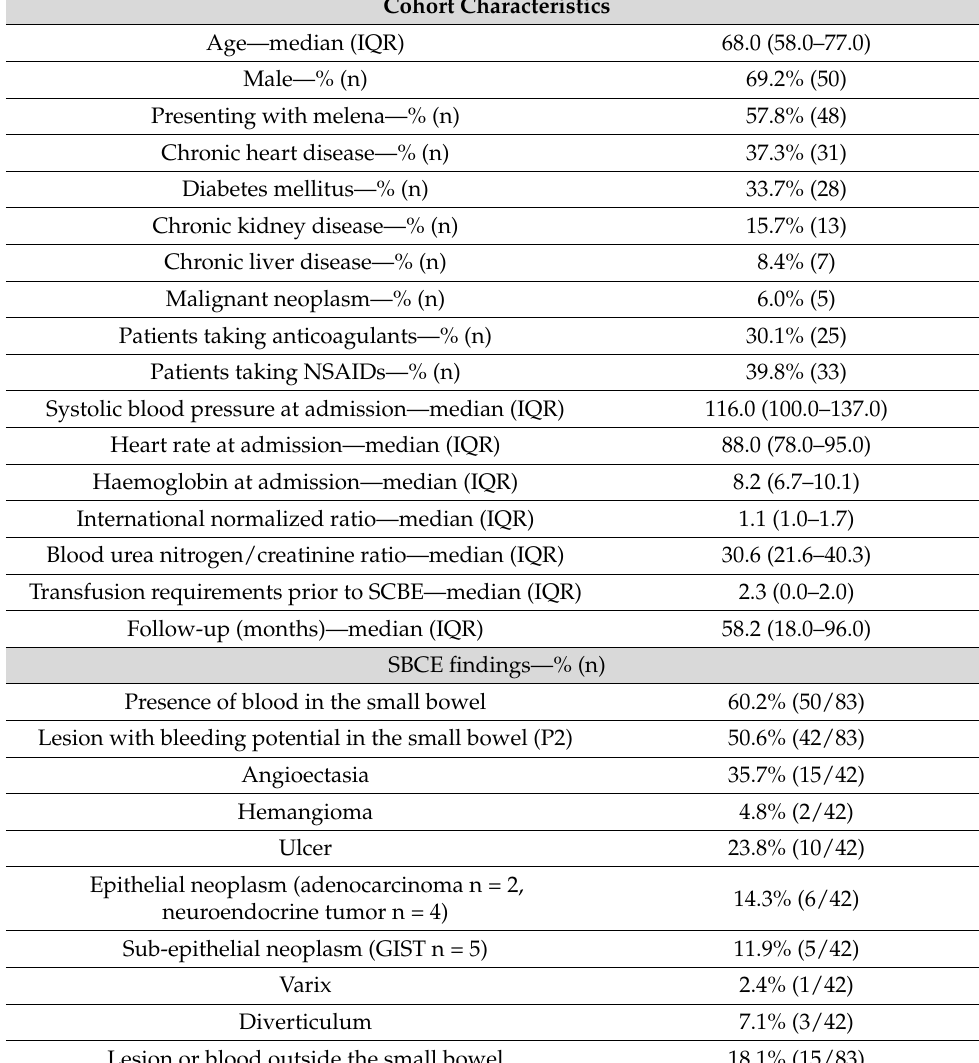
Table 1. Baseline characteristics of the cohort performing small-bowel capsule endoscopy (SBCE) in the first 48 h after hospital admission and SBCE